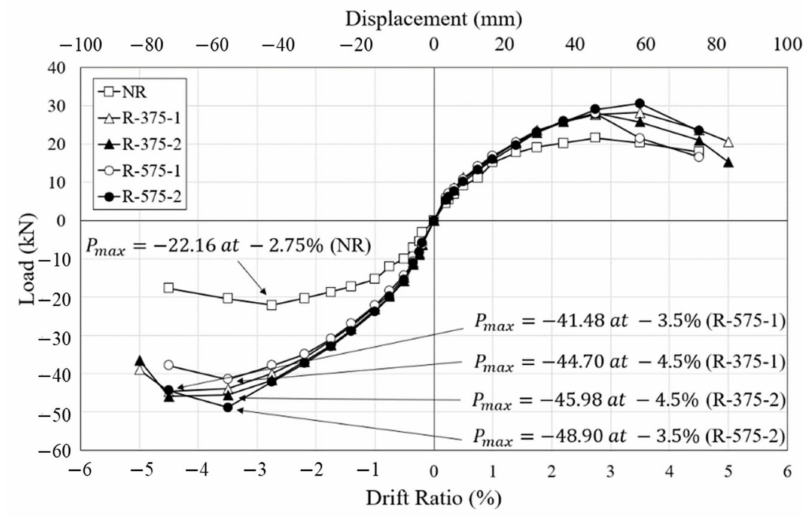
Figure 11. Envelope